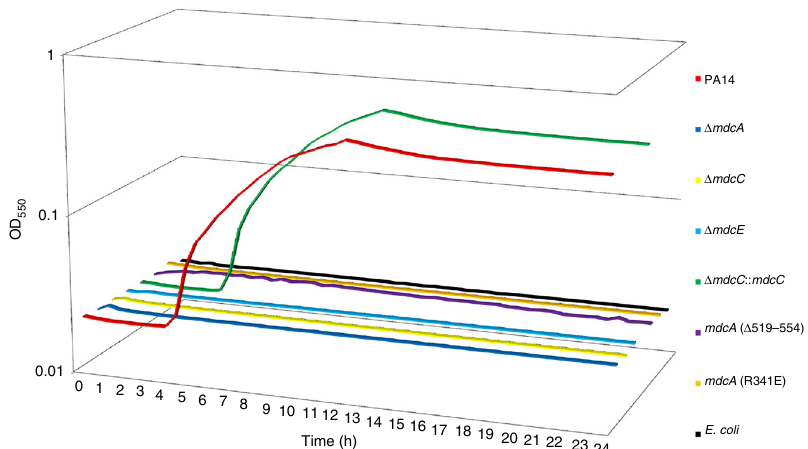
Figure 7 Impact of mutations in MDC holoenzyme subunits on growth with malonate as the sole carbon source. Individual deletion of genes for the MdcA, MdcC, or MdcE subunit in P. aeruginosa abolished growth on malonate. Insertion of the coding sequence for the MdcC subunit at the mdcC deletion site restored growth. Deletion of MdcA residues 519 – 554 (required for MDC hetero-tetramer formation) and the R314E mutation in MdcA (involved in recognition of malonate in the active site) also abolished growth. Finally, Escherichia coli , which is not able to grow on malonate as a sole carbon source, served as a negative control. Attempts at deleting the MdcD subunit were not successful. Results from one representative experiment from three biological replicates are